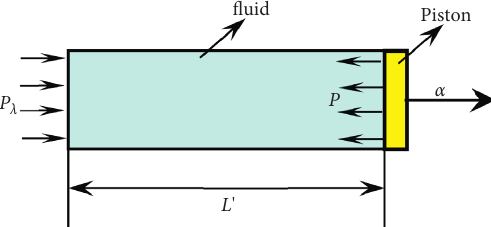
Figure 7: Plunger cavity fluid mechanical